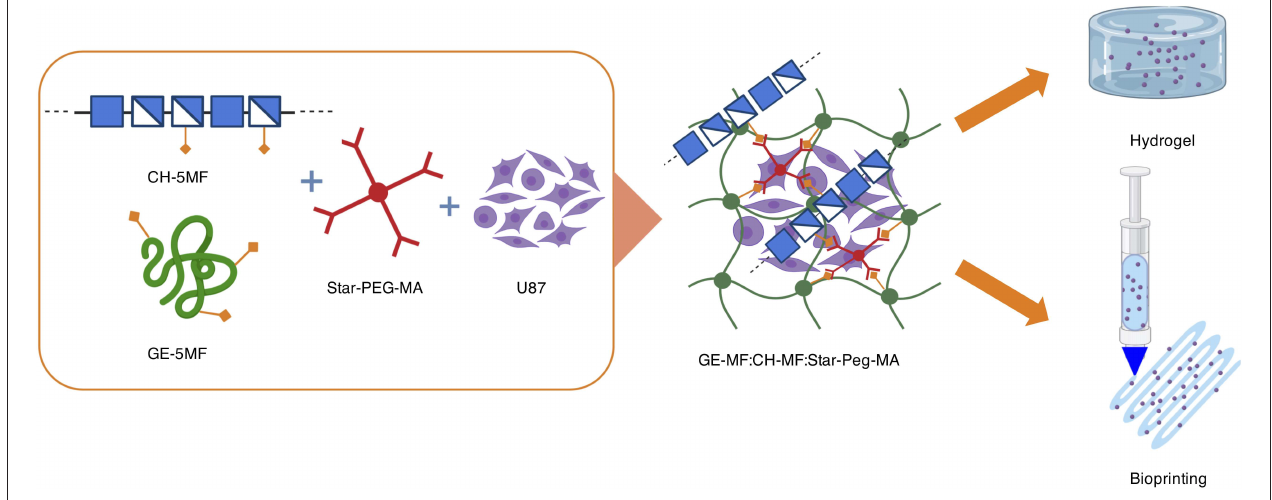
FIGURE 1 | Graphical representation of hybrid formation, cell encapsulation, and formulation in a cell-laden hydrogel bioprinted construct.